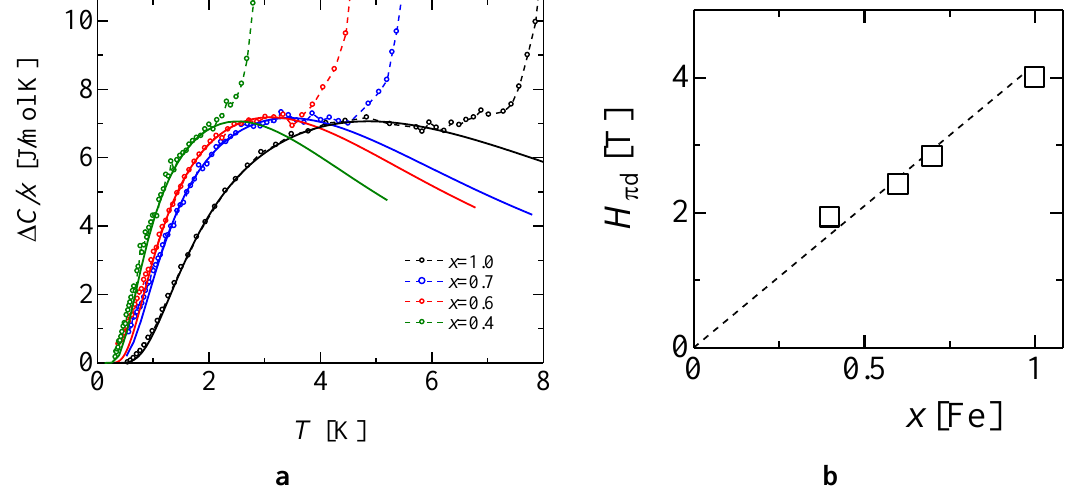
Figure 8. ( a ) Temperature dependencies of excess specific heat divided by Fe content Δ C / x . The solid curves show the 6-level Schottky specific heats, which are based on the paramagnetic 3 d spin ( s = 5/2) system under the internal magnetic field H maximum of the Schottky specific heat shifts to lower temperature with decreasing H